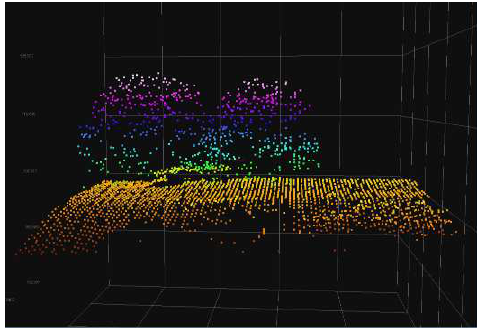
Figure 3. Visualization of tree canopies